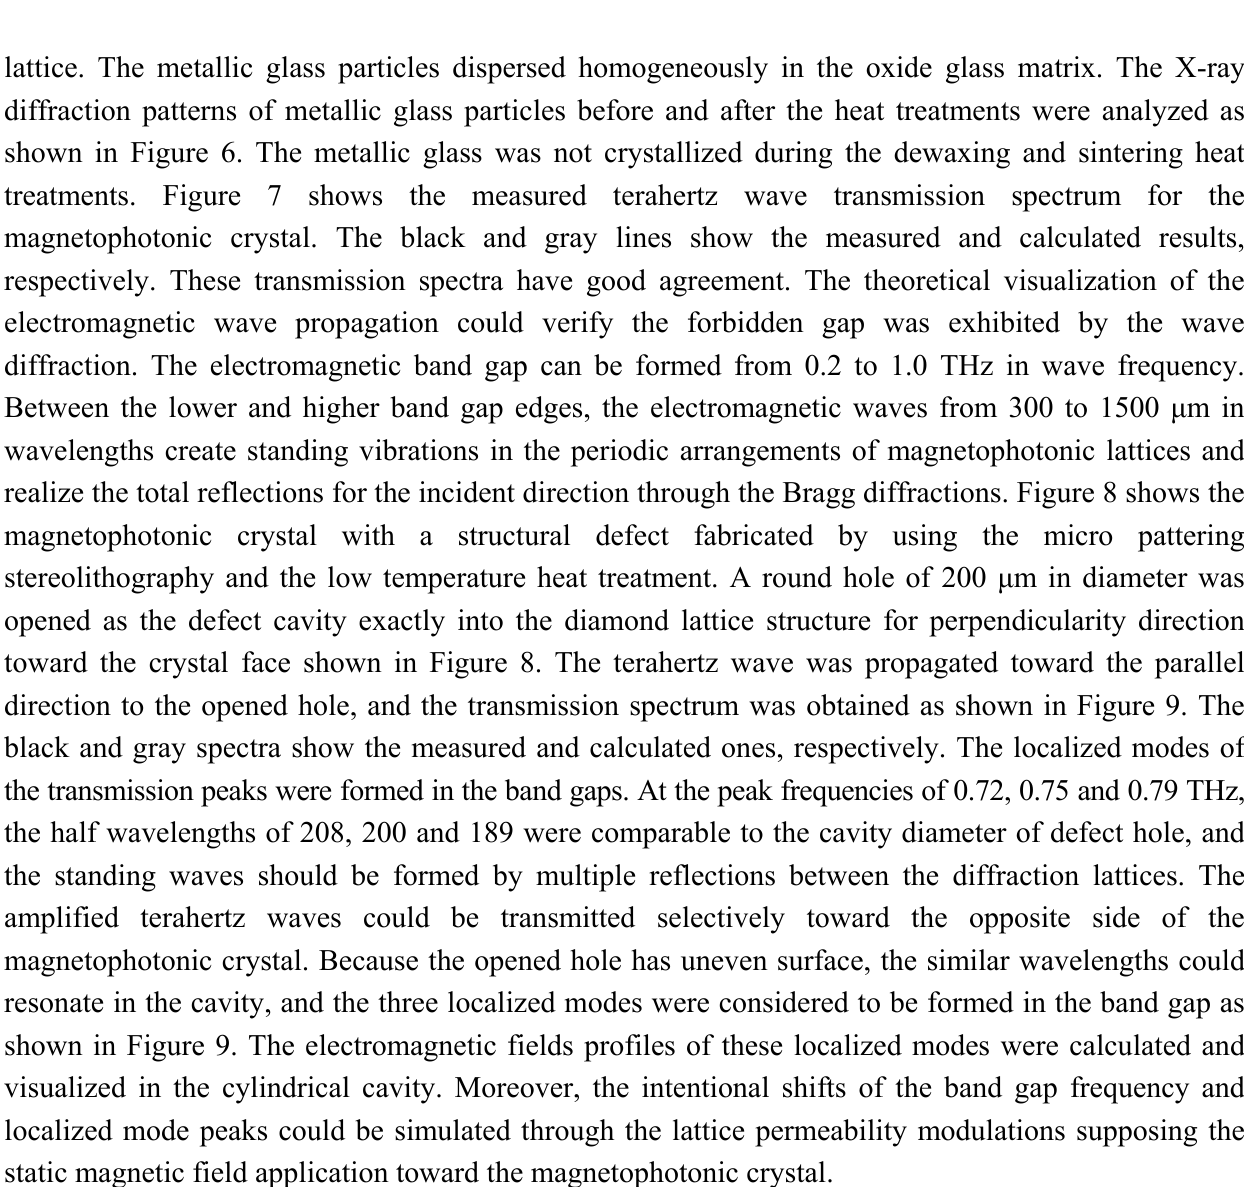
B Si Nb ) and oxide glass 72 14.4 9.6 4